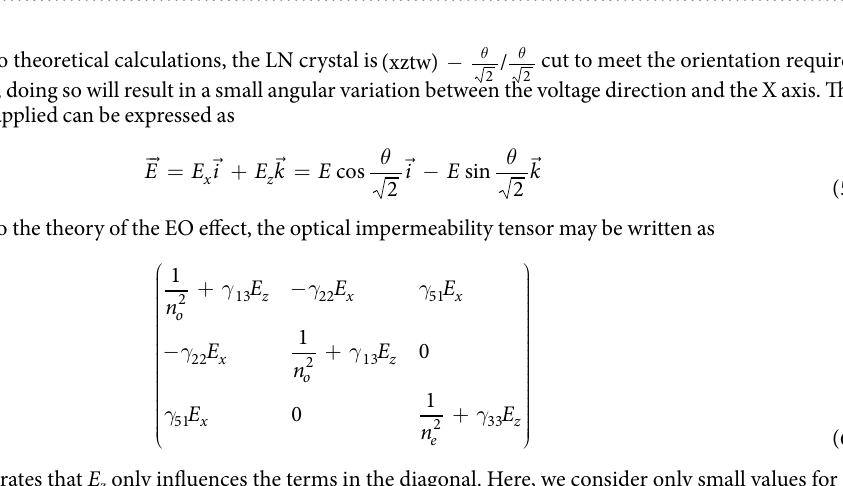
Figure 1. Eigen polarization direction of the wave in crystal for an electrical field applied. X, Y, and Z axes along each crystallographic axis respectively, k represents wave normal direction, P 1 and P 2 are eigen polarization